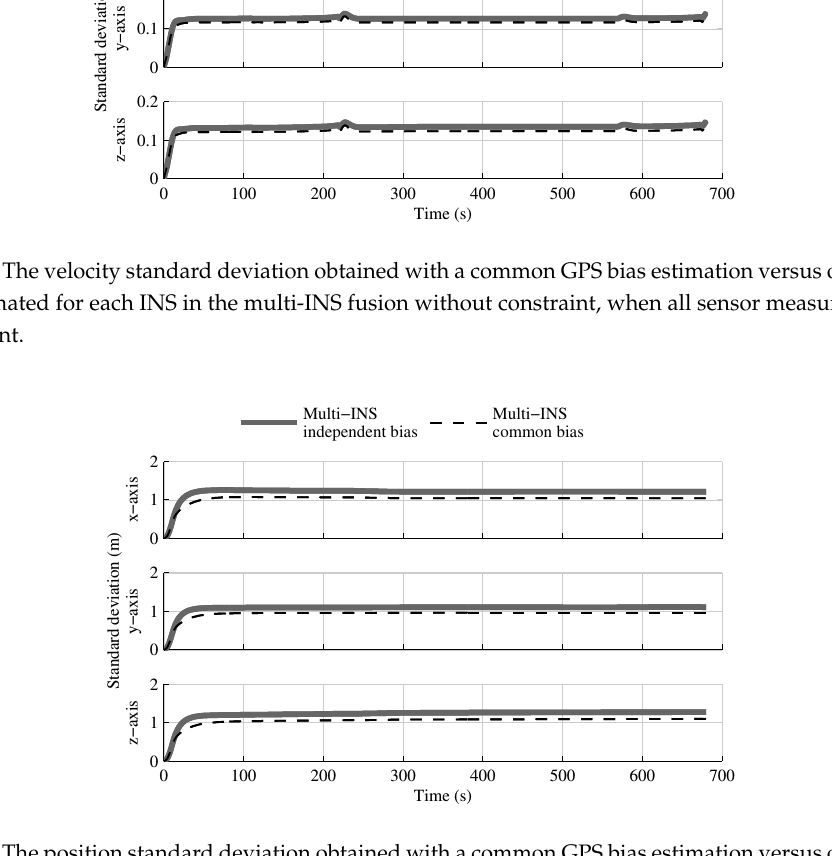
Figure 9. The position standard deviation obtained with a common GPS bias estimation versus one GPS bias estimated for each INS in the multi-INS fusion without constraint, when all sensor measurements are